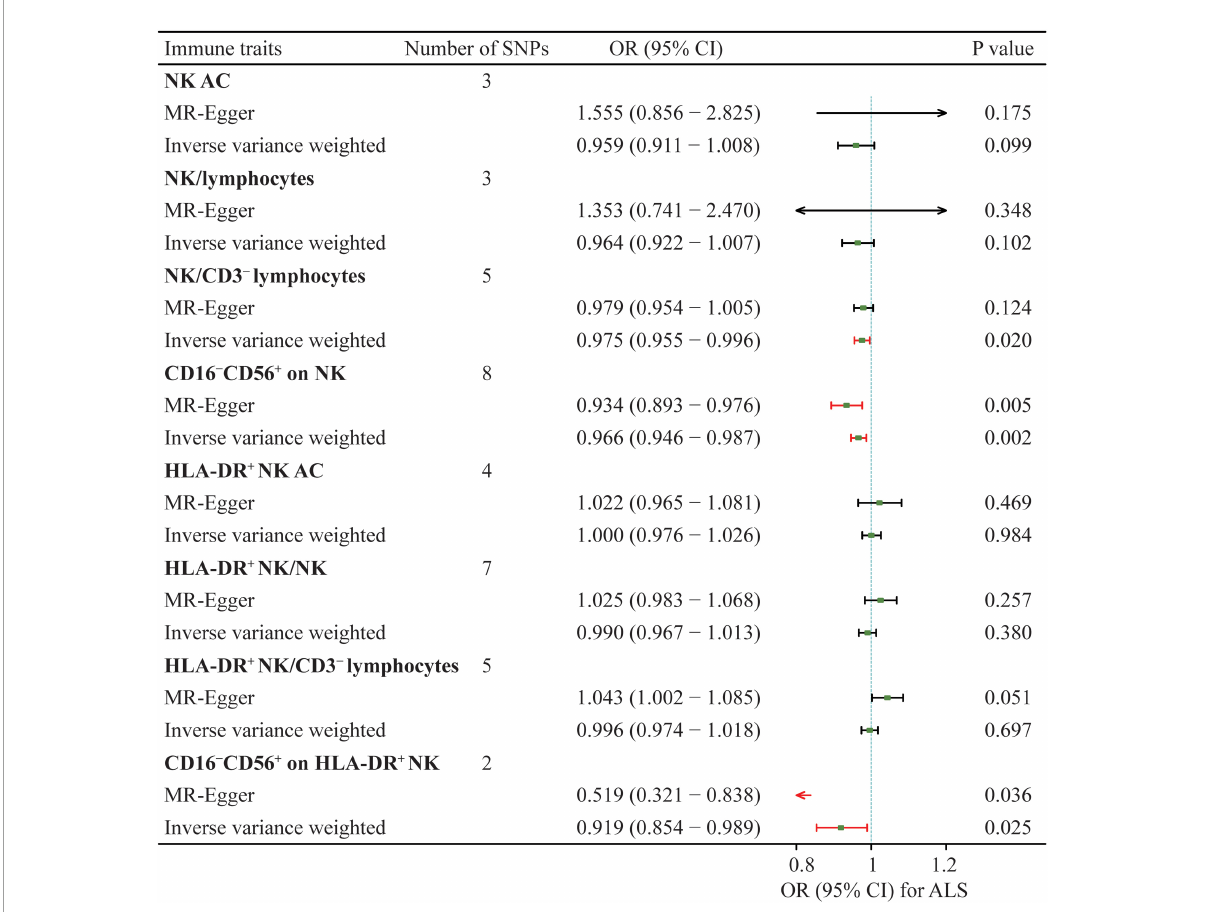
FIGURE2 Summary of the causal effects of NK cells-related immune traits on ALS with mendelian randomization. ALS, amyotrophic lateral sclerosis; SNP, single nucleotide polymorphism; NK, natural killer cells; HLA, human leucocyte antigen; OR, odds ratio; CI, confidence interval.